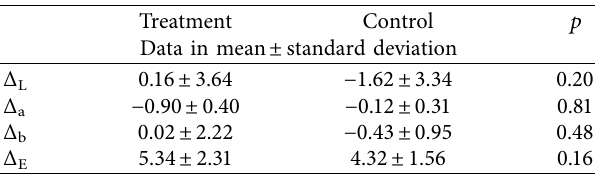
Table 3: L ∗ , a ∗ , b ∗ , and Δ E values for the treatment group ( n � 19) and the control group ( n �